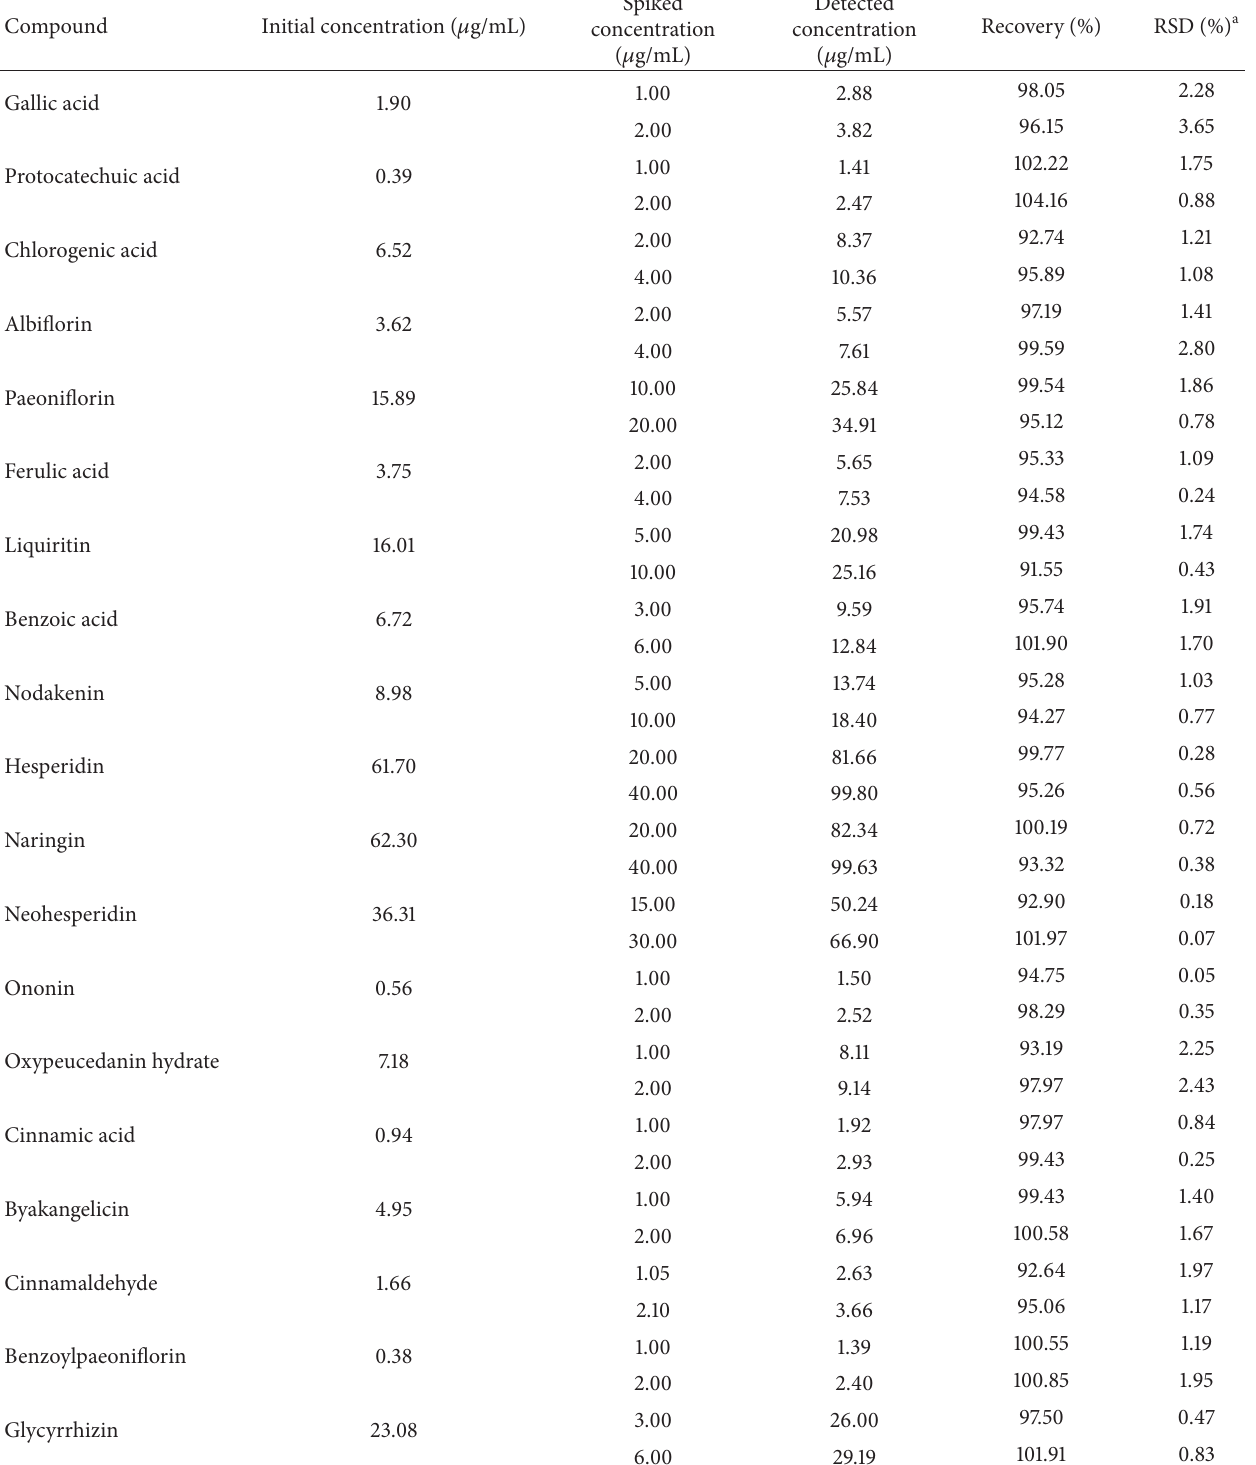
Table 4: Recovery of the marker compounds of OJS ( 𝑛 = 3